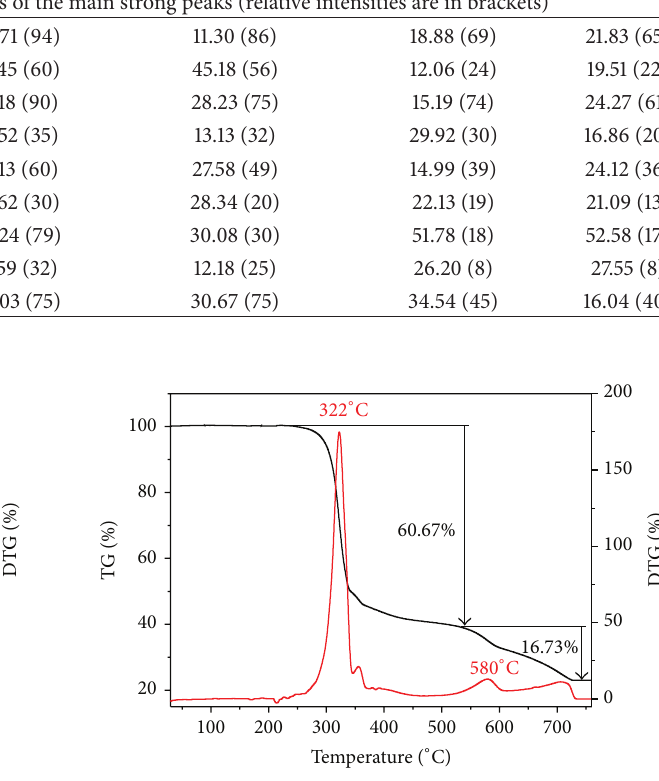
Table 4: The data for X-ray powder diffraction patterns of the complexes and biuret. Compound